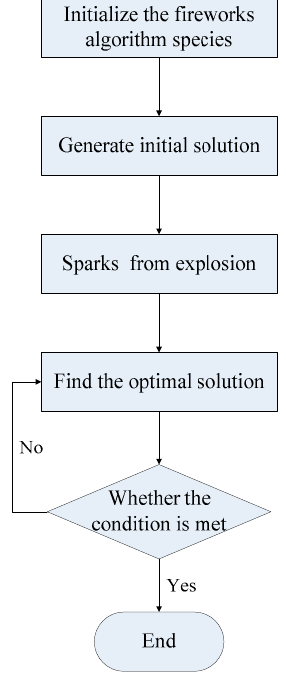
Figure 11. Chart of fireworks algorithm.